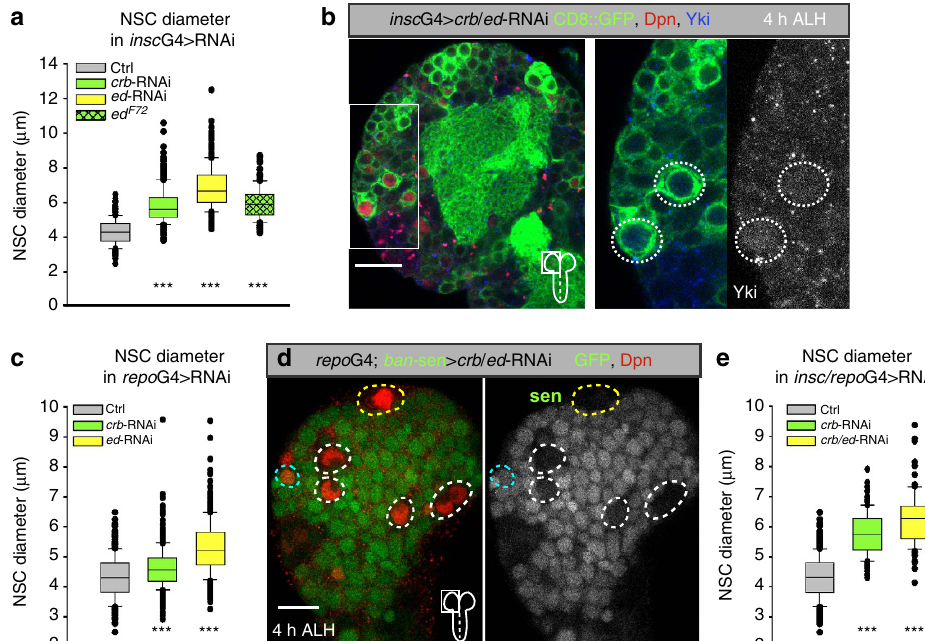
Figure 5 | Crumbs and Echinoid are required in NSCs and glial cells in cis and in trans to activate SHWduring quiescence. ( a ) Quantification of NSC cell diameters in NSC-specific RNAi ( insc G4) of crb or ed and in the ed F72 mutant at 4h ALH. *** P o 0.001. Wilcoxon rank sum test. Median and s.d. were calculated from two biological replicates. Control brain n ¼ 355 NSCs (7 brain lobes); insc G4 4 crb -RNAi, n ¼ 313 NSCs (7 brain lobes); insc G4 4 ed -RNAi, shows a magnification of the marked area in the left panel. In the right panel only Yorkie (blue) and GFP (green) or Yorkie alone (monochrome) are shown. ( c ) Quantification of NSC cell diameters in Glia-specific RNAi ( repo G4) of crb or ed at 4h ALH. *** P o 0.001. Wilcoxon rank sum test. Median and s.d. were calculated from two biological replicates. Control brain n ¼ 255 NSCs (5 brain lobes); repo G4 4 crb -RNAi, n ¼ 458 NSCs (9 brain lobes); repo G4 4 ed -RNAi, n ¼ 388 NSCs (7 brain lobes). ( d ) Glial-specific crb / ed RNAi leads to premature bantam activity (loss of GFP) in NSCs (red, Deadpan) at 4h ALH. Right panel shows GFP ( ban -sensor, monochrome) signal alone. ( e ) Quantification of NSC cell diameters in Glia- and NSC-specific RNAi ( insc G4; repo G4) of crb or Crumbs /ed at 4h ALH. *** P o 0.001. Wilcoxon rank sum test. Median and s.d. were calculated from two biological replicates. Control brain n ¼ 145 NSCs (3 brain lobes); insc G4; repo G4 4 crb -RNAi, n ¼ 125 NSCs (3 brain lobes); insc G4; repo G4 4 crb / ed -RNAi, n ¼ 84 NSCs (2 brain lobes). All images are single focal planes, anterior up. Scale bar, 10 m m. See also Supplementary Fig.